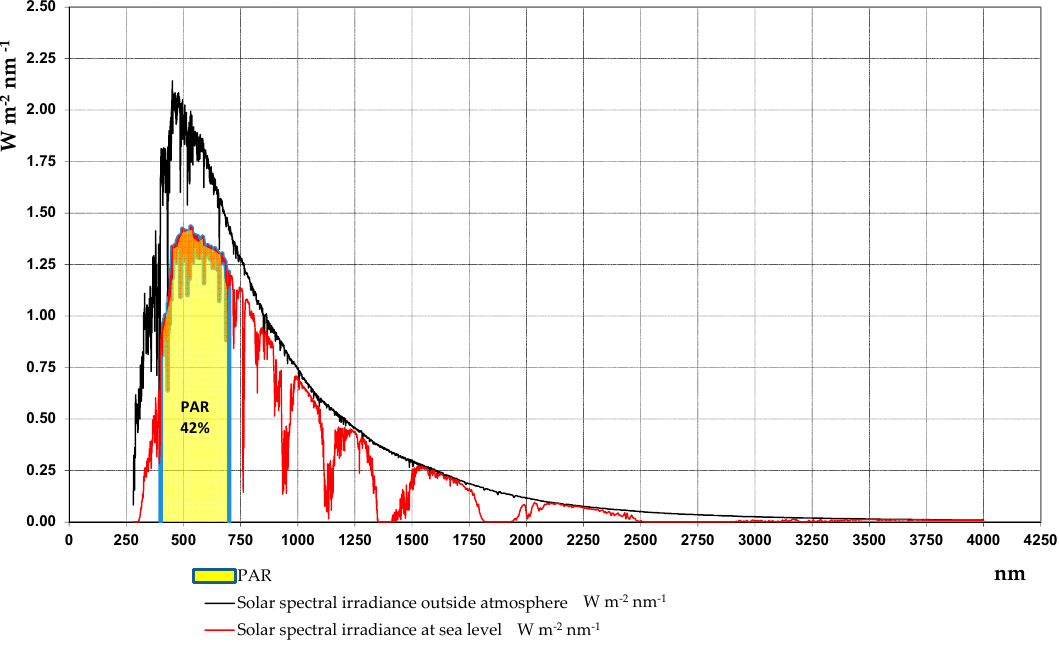
Figure 6. The solar spectral irradiance and photosynthetic active radiation (PAR) ( µ mol s − 1 m − 2 ). Table 2. Minimum and maximum levels of PAR ( μ mol m − 2 s − 1 ) required by some plant species and converted into visible solar radiation (W m − 2 ).